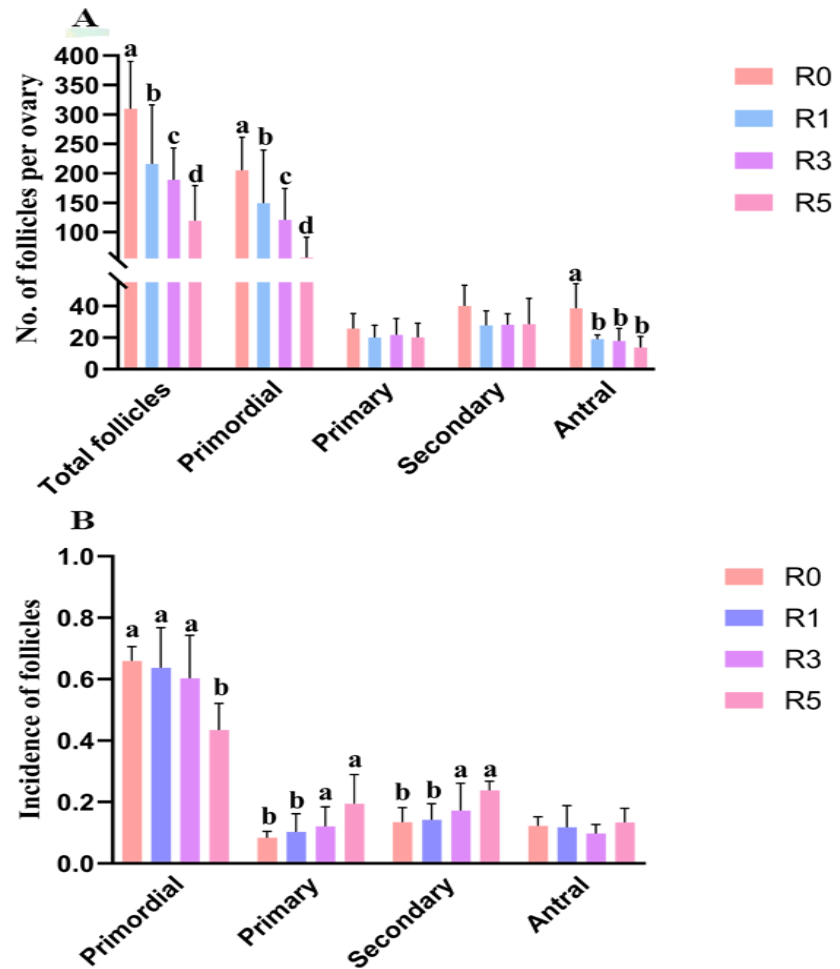
Figure 2. Follicles in ovaries. ( A ), the number of different stage follicles in ovaries; ( B ), the ratios of follicles at different stages. The same letters mean the statistical difference was not significant between groups ( p > 0.05, unpaired t -test); different letters mean the statistical difference was significant between groups ( p < 0.05, unpaired t- test).